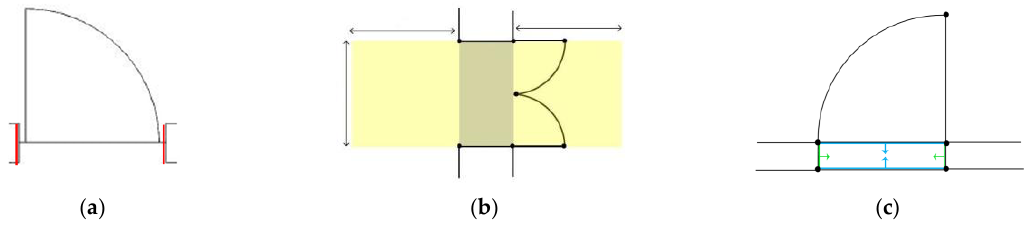
Figure 6. ( a ) Red lines represent pairwise edges. ( b ) Search area around the potential door in both directions. ( c ) Lines (blue) are added as a wall continuation. Every segment gets a vector directed to the inside of the element.